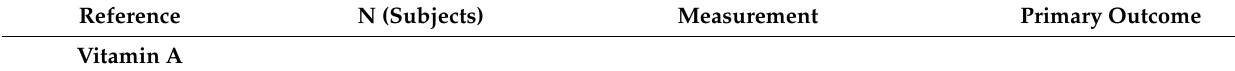
Table 1. Studies on association between circulating vitamin levels and diabetic retinopathy .